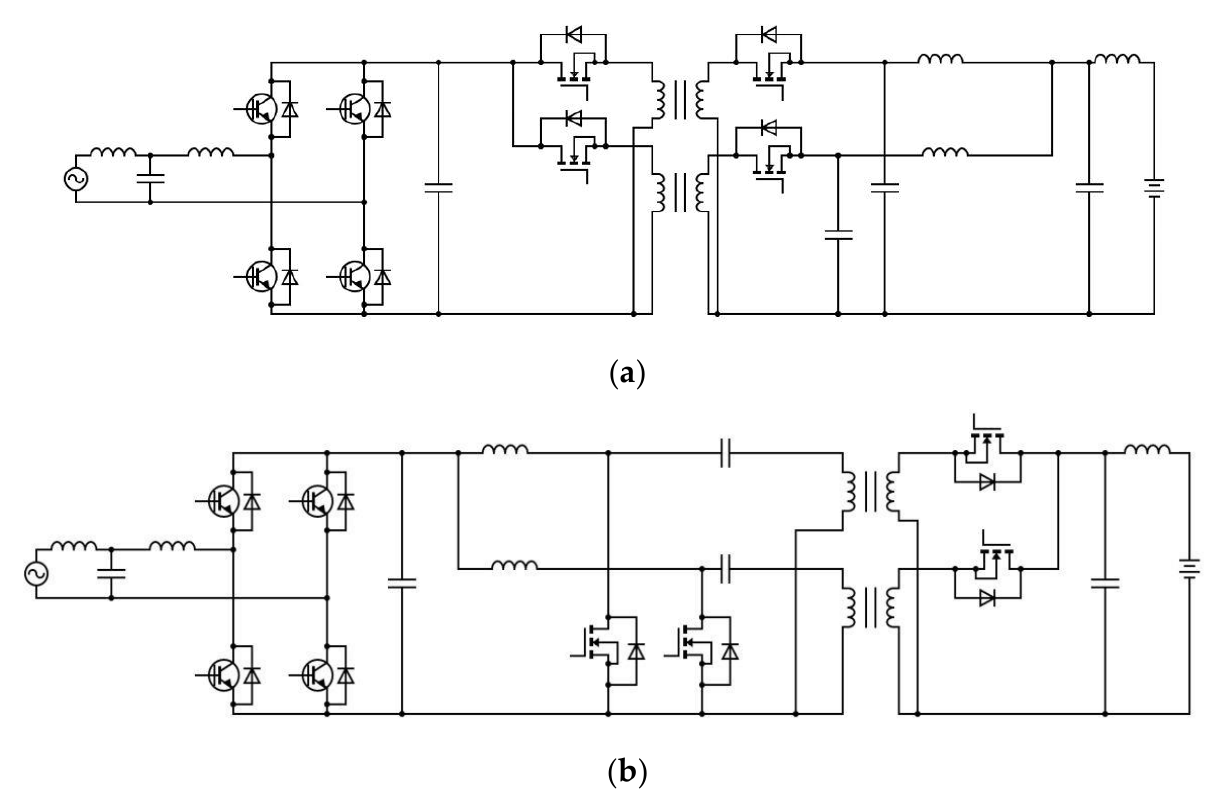
Figure 12. ( a ) Interleaved isolated Luo converter-based topology [45] ( b ) Interleaved isolated SEPIC converter-based topology [46].